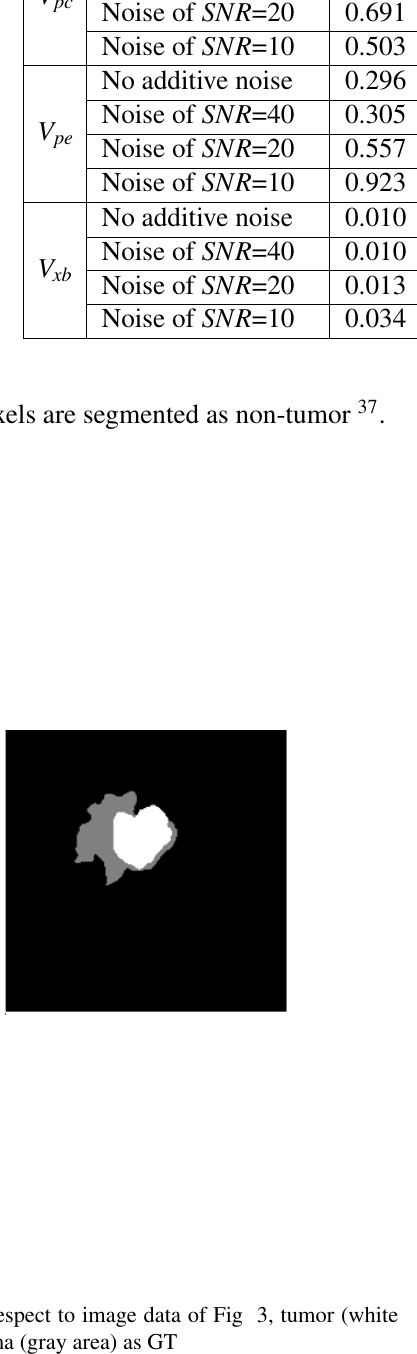
Fig. 6. With respect to image data of Fig 3, tumor (white area) and edema (gray area) as GT